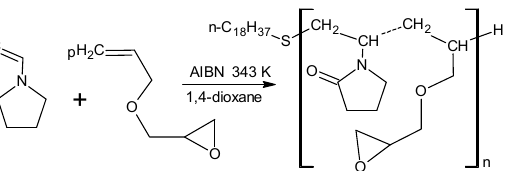
Scheme 1. Synthesis of an amphiphilic copolymer of N-vinyl-2-pyrrolidone and allyl glycyl ether